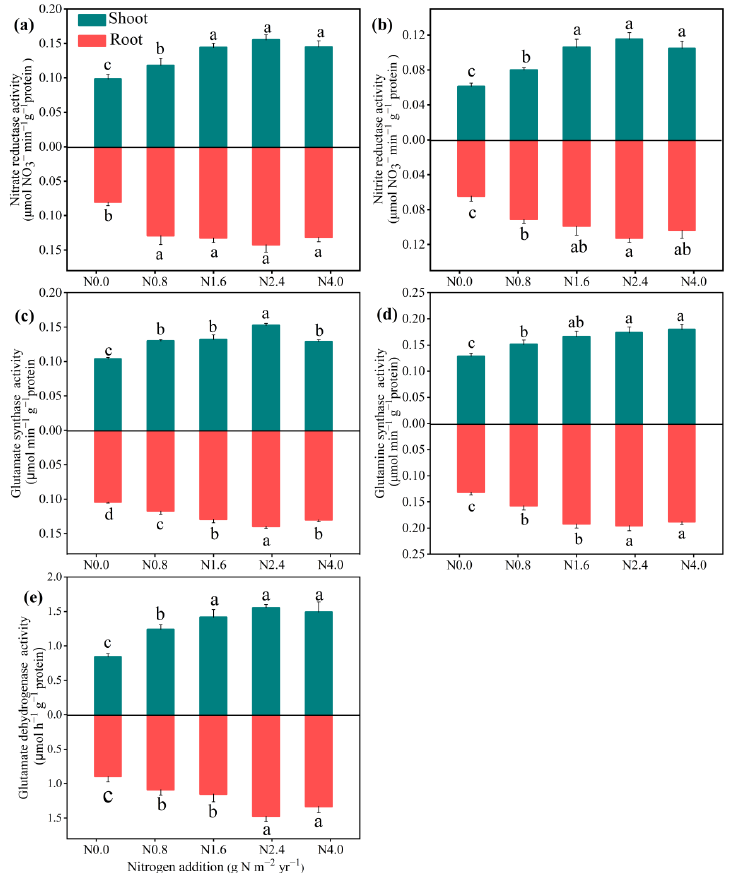
Figure 3. Effects of N addition on N metabolism enzymatic activities of A. mongolicum . Values are the mean ± standard error ( n = 4). Different letters above the bars indicate significance differences among the N addition treatments ( p < 0.05). ( a ) nitrate reductase (NR), ( b ) nitrite reductase (NiR), ( c ) glutamine synthetase (GS), ( d ) glutamate synthase (GOGAT), and ( e ) glutamate dehydrogenase (GDH).